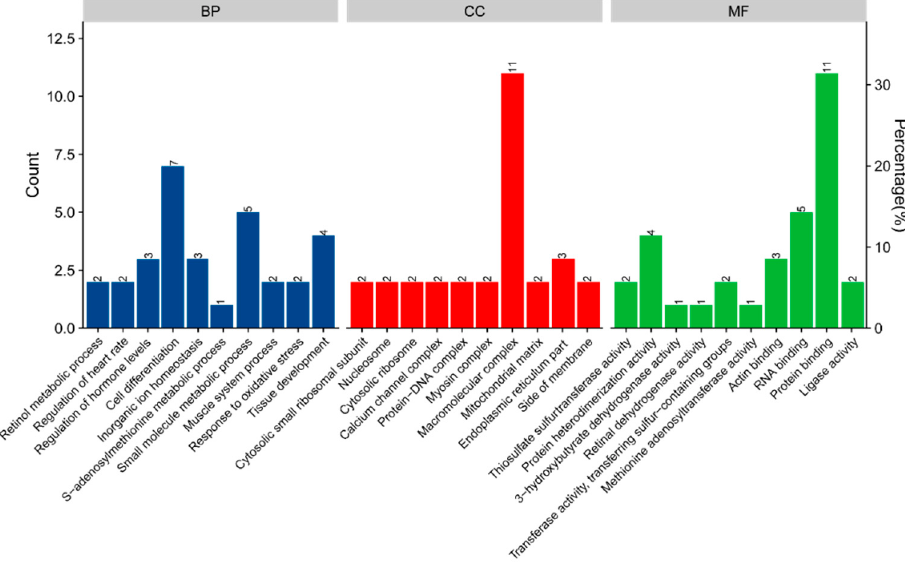
Figure 2. Enrichment of GO analysis of 35 DAPs in breast muscle of broilers fed betaine dietary. BP—biological process; CC—cellular component; MF—molecular function.